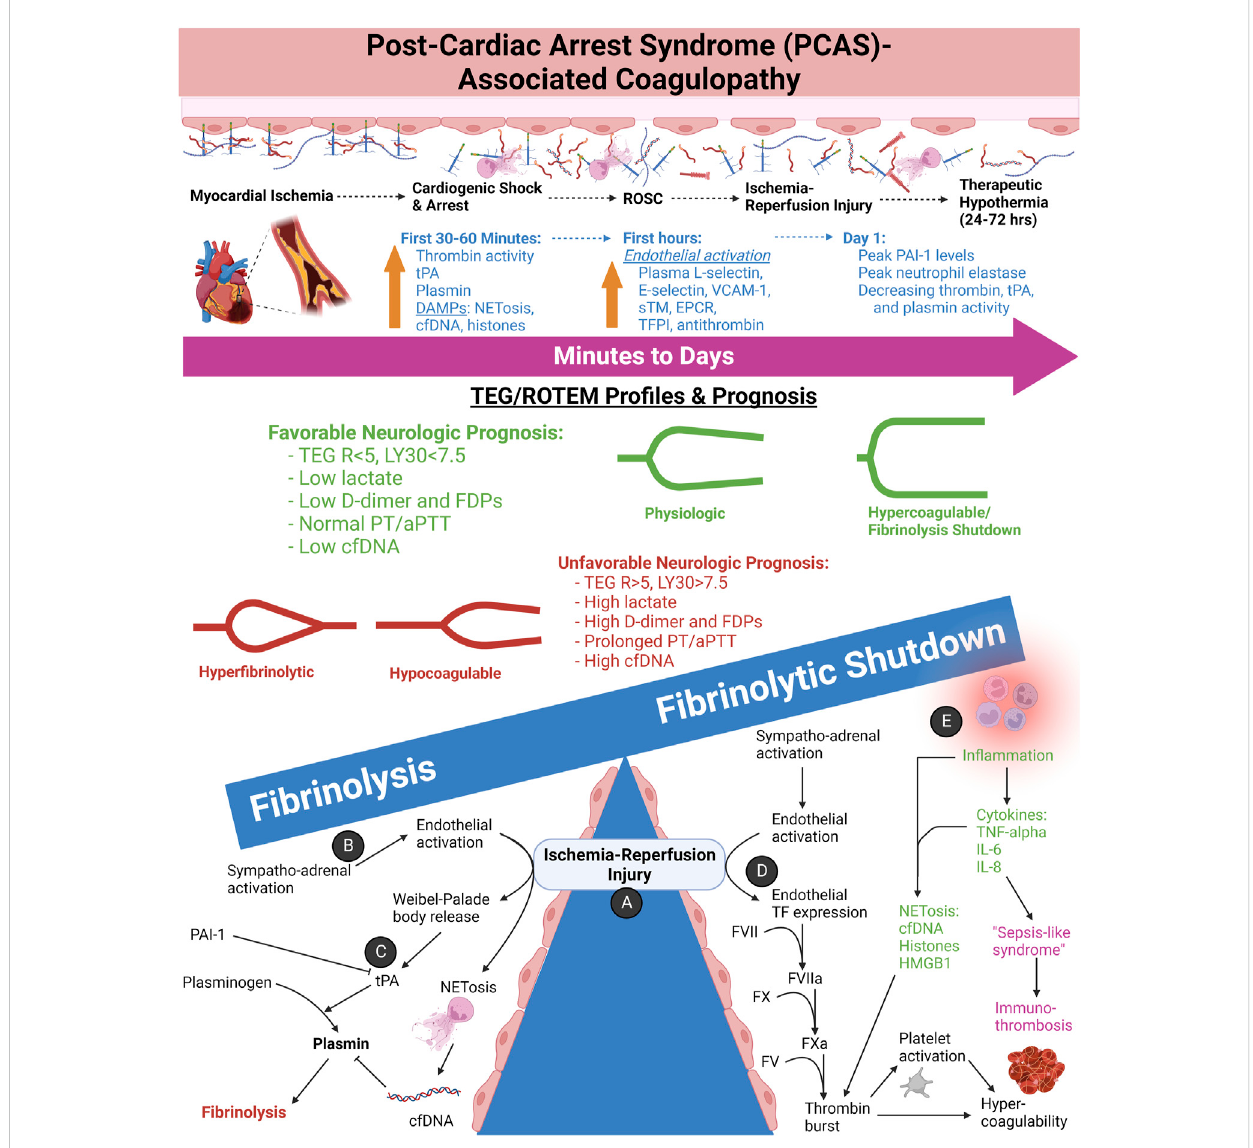
FIGURE 10 The Spectrum of Post-Cardiac Arrest Syndrome (PCAS)-associated Coagulopathies and Neurologic Prognostication by TEG/ROTEM. (A) In cardiac arrest, ischemia af fl icts every tissue in the body. Depending on the length of arrest, necrosis results for many tissue types, resulting in an acute in fl ammatory response. Return of spontaneous circulation (ROSC) further promotes in fl ammation by reperfusion of oxygen, thereby increasing the generation of reactive oxygen species by the now resident in fl ammatory cells. (B) As a result of the shock state and epinephrine infusion during resuscitation, the activated endothelium becomes pro-thrombotic and simultaneously fi brinolytic via Weibel-Palade body (WPB) exocytosis as one such mechanism. (C) Widespread release of tissue plasminogen activator (tPA) by the endothelium promotes conversion of plasminogen to plasmin. Circulating cell free DNA (cfDNA), either from neutrophil extracellular traps (NETs) or necrotic cells, has demonstrated to inhibit plasmin activity to a degree.Circulatingplasminogenactivatorinhibitor-1(PAI-1)alsoservestodecrease fi brinolyticactivity;however,asanacutephasereactant,PAI-1levels have shown to peak at 24 h following ROSC. Platelet activation and release of α -granule contents PAI-1, TAFI, FXIIIa, and α 2-antiplasmin likely also contribute. Hyper fi brinolysis and/or hypocoagulability prognosticate poor neurologic outcomes. These hemostatic phenotypes arise more commonly with longer times to achieve ROSC. TEG measurements of reaction time (R) > 5 min and lysis at 30 min (LY30) > 7.5% following ROSC tend to have poor neurologicoutcomes.Intandem,prolongedprothrombintime(PT)andactivatedpartialthromboplastintime(aPTT)andincreasedmarkersof fi brinolysis (e.g., D-dimer and fi brin [ogen] degradation products) also prognosticate poor outcomes. Increased markers of tissue ischemia and necrosis such as lactate and cfDNA follow a similar worse prognosis. (D) Endothelial activation promotes thrombosis by increased Tissue Factor (TF) expression by both increased extracellular vesicles bearing TF, but also by necrotic cells releasing free TF systemically. (E) The ensuing in fl ammatory state in response to ischemia promotes immuno-thrombosis via several mechanisms, but namely via NETs catching and activation of circulating platelets as well as pro- thromboticproteins from necrotic tissues suchas cfDNA,histones,and High MobilityGroup Box-1 (HMGB-1).The in fl ammatorystate observedclinically in PCAS patients has been aptly termed “ Sepsis-like syndrome ” because of the systemic in fl ammatory response syndrome without an infectious source (Wada, 2017; Yu et al., 2020). Important to note, however, that hyper fi brinolysis in PCAS appears to be caused primarily by hypoperfusion rather than in fl ammation (Zipperle et al., 2022b). Abbreviations: aPTT, activated Partial Thromboplastin Time; cfDNA, cell free DNA; DAMPs, Damage-Associated Molecular Patterns; EPCR, endothelial Protein C Receptor; FDPs, Fibrin(ogen) degradation products; HMGB-1, High Mobility Group Box 1; IL, Interleukin; LY30, Lysis at 30 min; NETs, Neutrophil Extracellular Traps; PAI-1, Plasminogen Activator Inhibitor-1; PT, Prothrombin Time; R, Reaction time; sTM, soluble Thrombomodulin; TFPI, Tissue Factor Pathway Inhibitor; TNF-alpha, Tissue Necrosis Factor-alpha; tPA, tissue Plasminogen Activator; VCAM-1, Vascular Cellular Adhesion Molecule-1. Created with